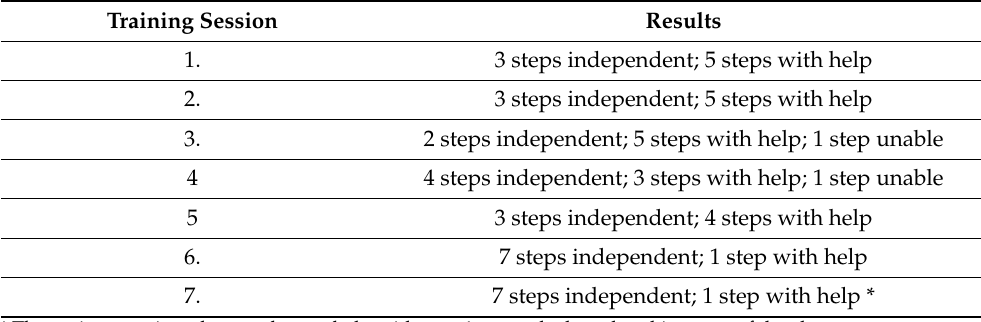
Figure 1. An example of the learning scheme ‘ironing’ as shown in the errorless learning application. Table 1. An example of the results on the learning scheme ‘ironing,’ as shown in the errorless learning application.